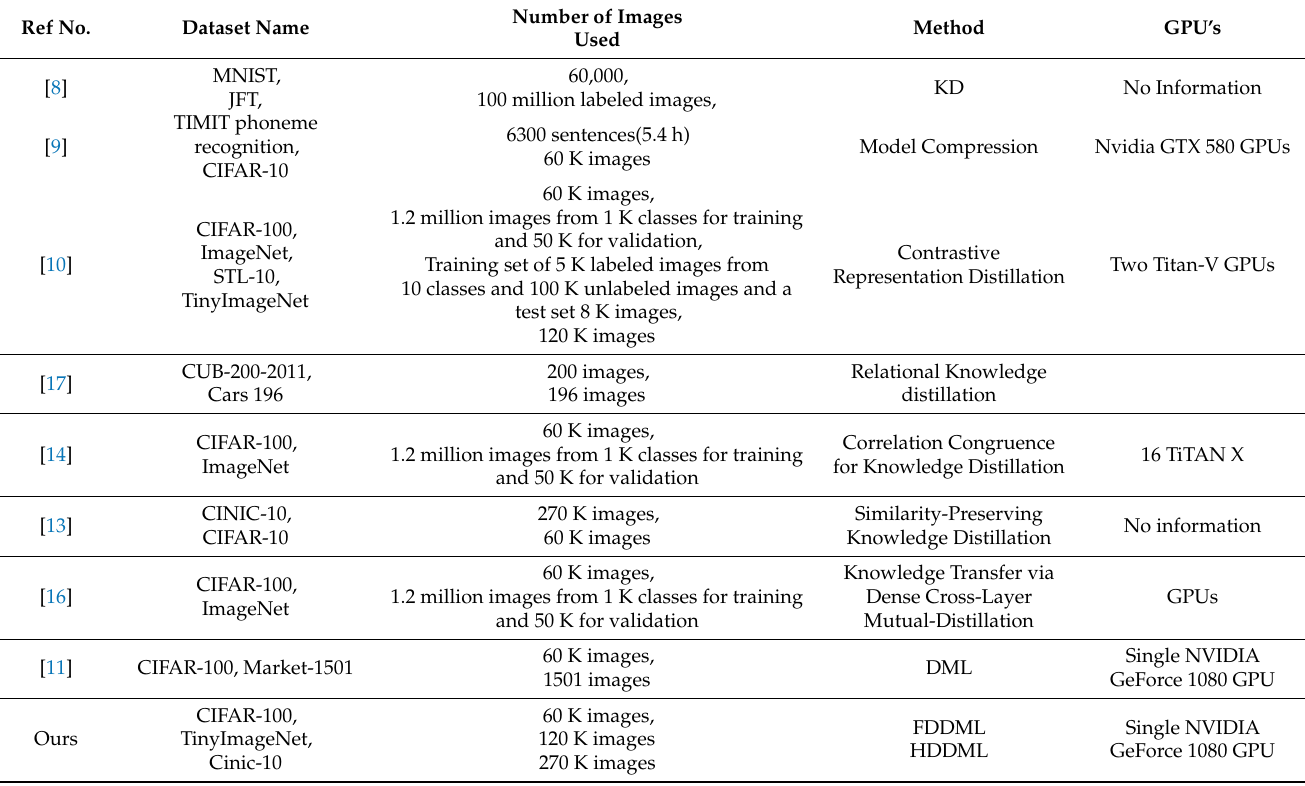
Table 1. Comparison of recent related